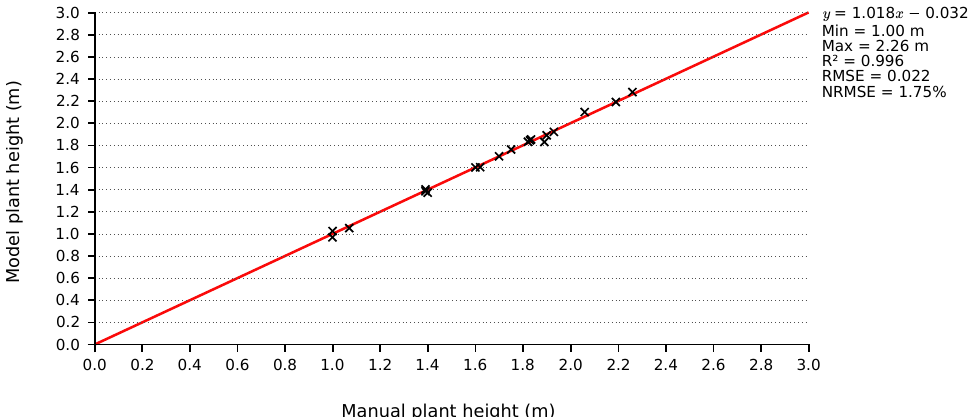
Figure 15. Scatter plot of plant height measurements; comparison between depth-based height and manual height